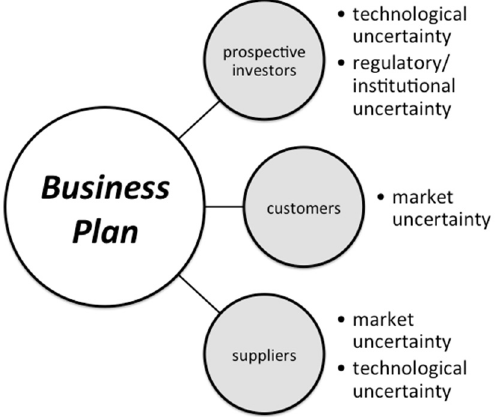
Figure 1. Addressing Uncertainty through the AMD Business